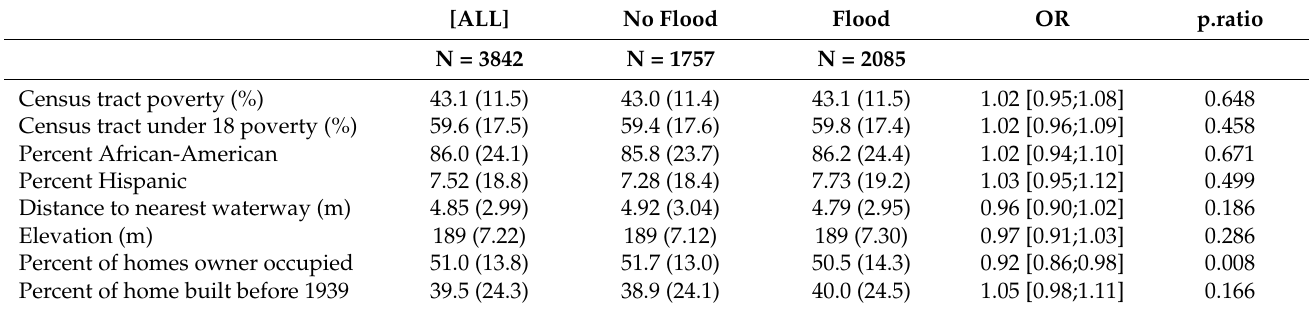
Table 3. Neighborhood and environmental determinants of recurrent home flooding. Odds ratio for continuous measures produced using standardized values